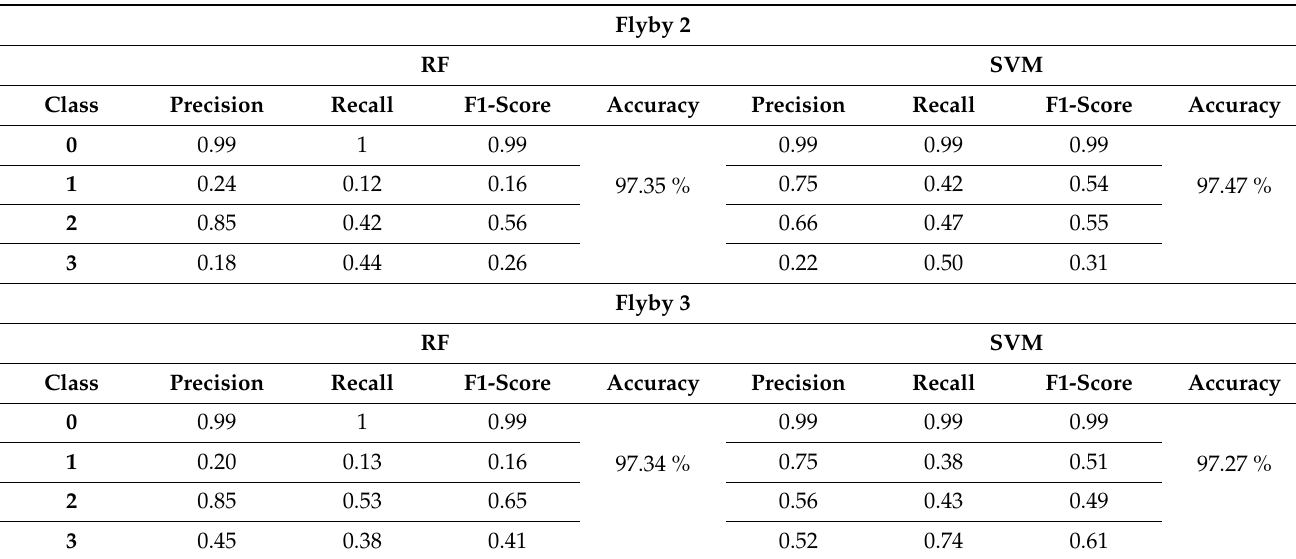
Table 6. Results obtained for the test data (20/09/2020 flight) for random forest (RF) and support vector machine (SVM)